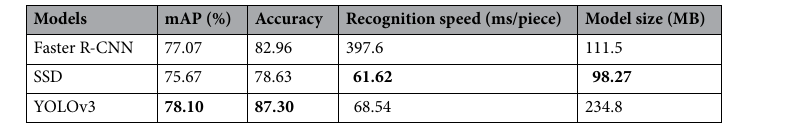
Table 9. Experimental results of Plan A. The bold values are meant to represent the best results obtained under the corresponding metric.